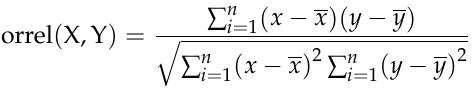
Table 3. Training and validation results for the artificial neural network (ANN) model: the maximum contour error (MCoE) and machining time (MT) and corner vibration (CVib).